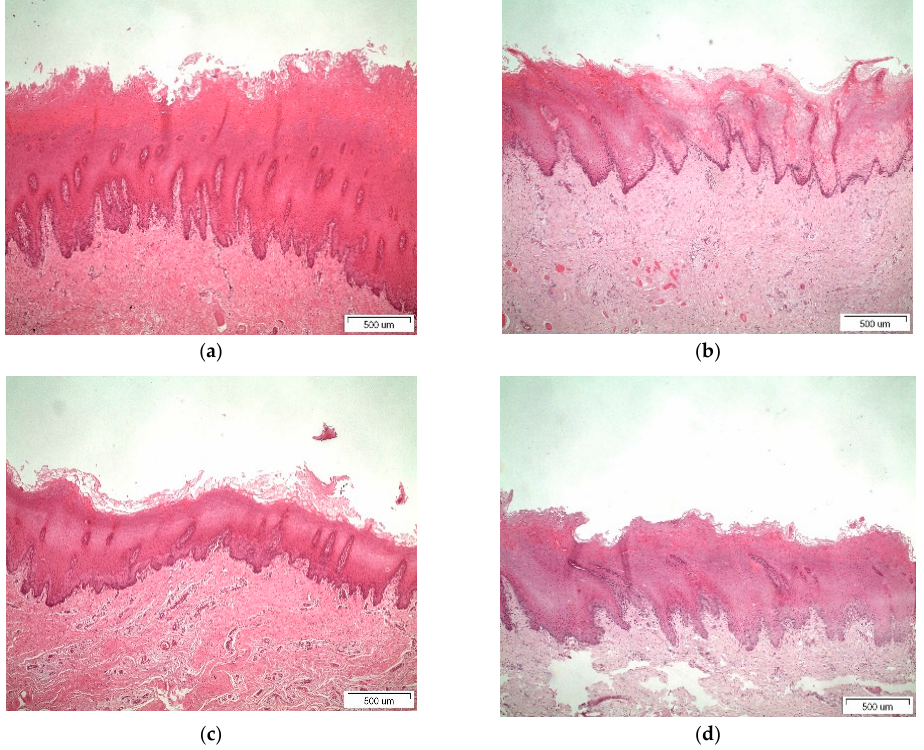
Figure 7. Light micrographs of ( a ) porcine buccal mucosa (untreated); ( b ) free complex with β -CD); ( c ) free complex with Me- β -CD; and ( d ) free complex with HP- β -CD. Bar represents 500 μ m.